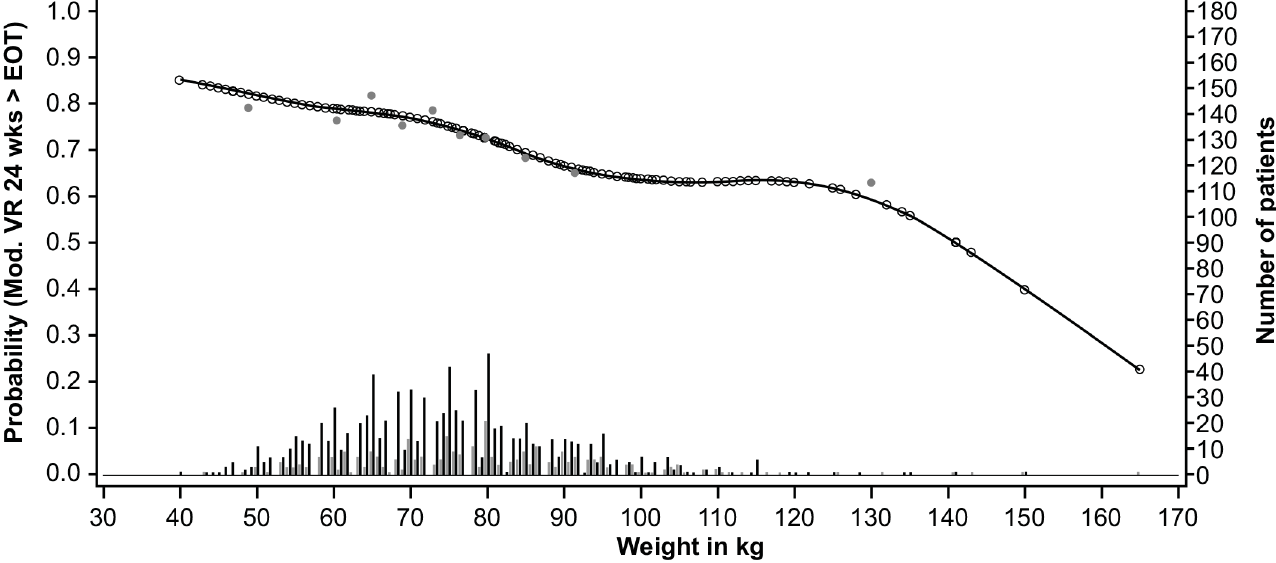
Fig 4. Relationship between bodyweight and sustained virologic response (SVR). Short vertical lines indicate the number of patients with SVR (black lines) and no SVR (grey lines). Open circles represent probability of SVR according to the GAM analysis. Closed circles represent empirical probability for midpoints of